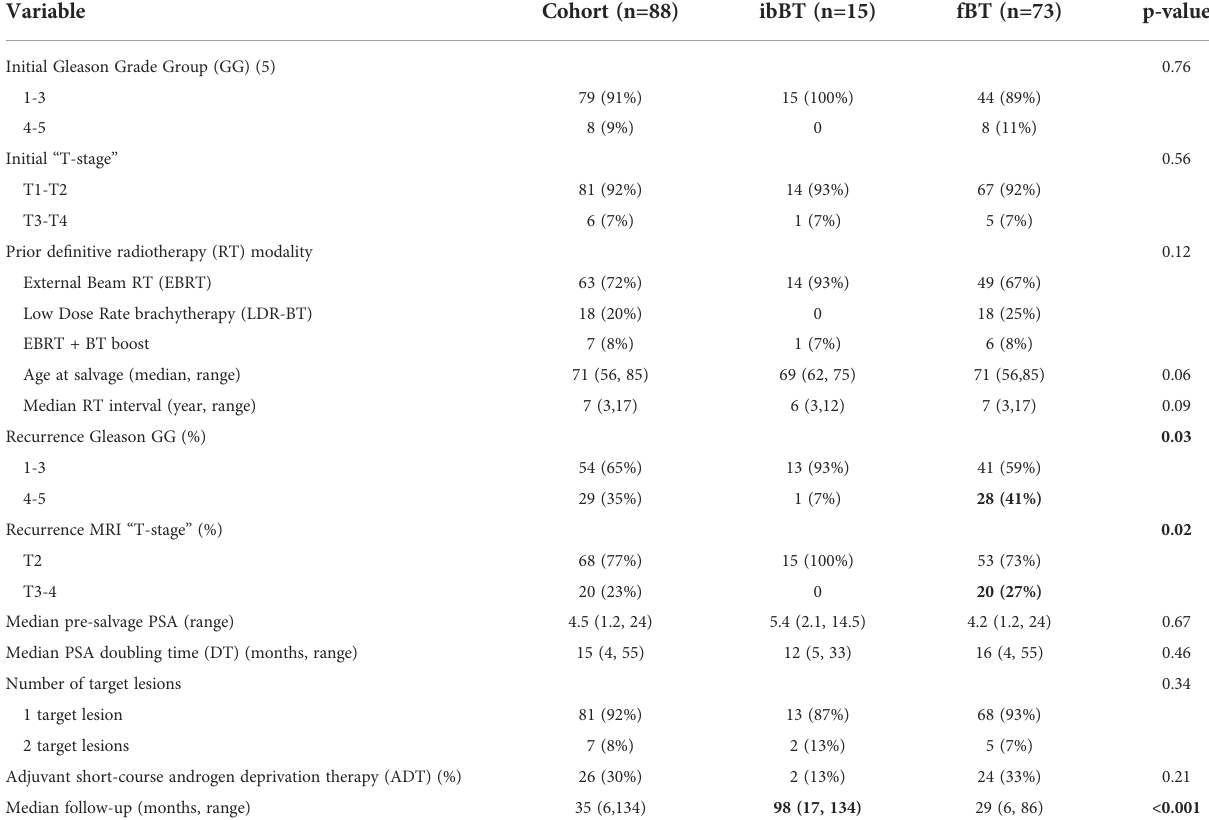
TABLE 1 Patient and treatment characteristics (cohort differences in bold).